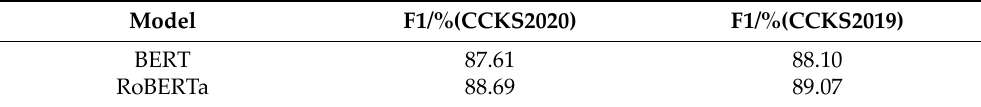
Table 4. Results of different pre‑trained